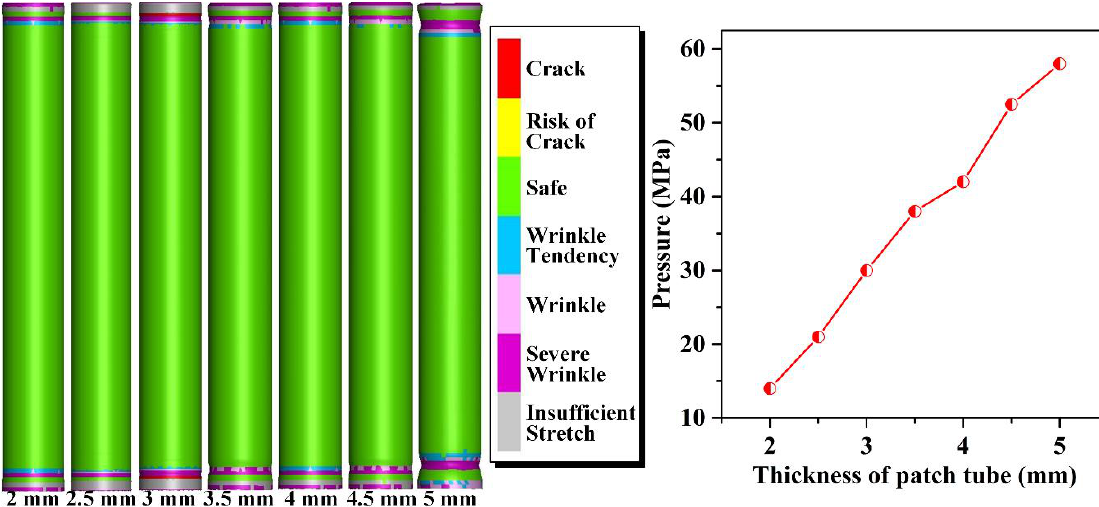
Figure 11. Influence of different outer diameters on forming pressure.